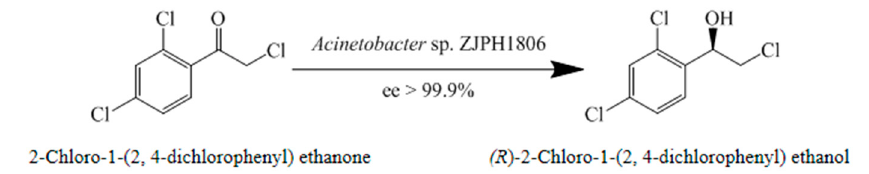
Figure 2. Asymmetric synthesis of ( R )-2-chloro-1-(2,4-dichlorophenyl) ethanol.